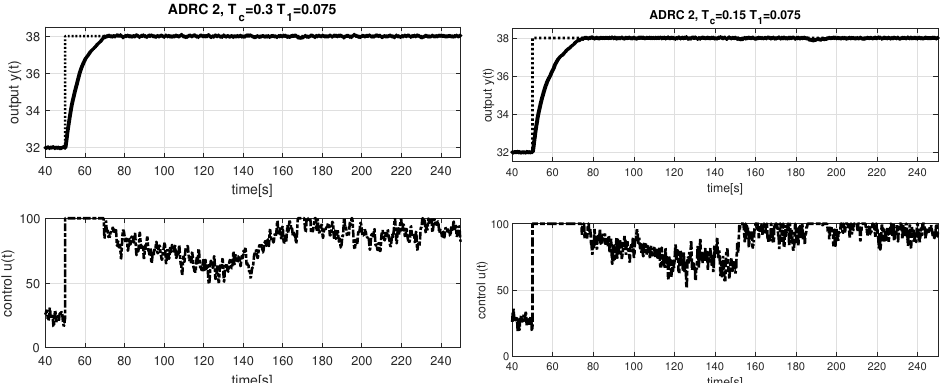
Figure 7. ADRC 2 : Transients corresponding to the controller in Figure 3 for T 1 = 0.075 in (40) and (41), T c = T d ( left ) and T c = T d /2 ( right ), T dm = T d = T d − T 1